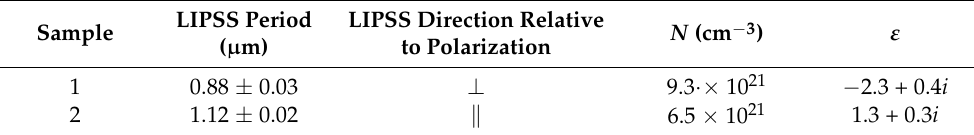
Figure 4. Results of the efficacy factor η ( κ x , κ y ) modeling for the samples ( a ) 1 and ( b ) 2, and their comparison with the Fourier-transformed SEM images of the LIPSS experimentally observed on the surface of corresponding samples ( c , d ). The arrows indicate the orientation of the laser radiation polarization vector. Table 2. LIPSS period and orientation, nonequilibrium electrons concentration N and the dielectric permittivity ε at the surface of a-Si:H films during irradiation with femtosecond laser